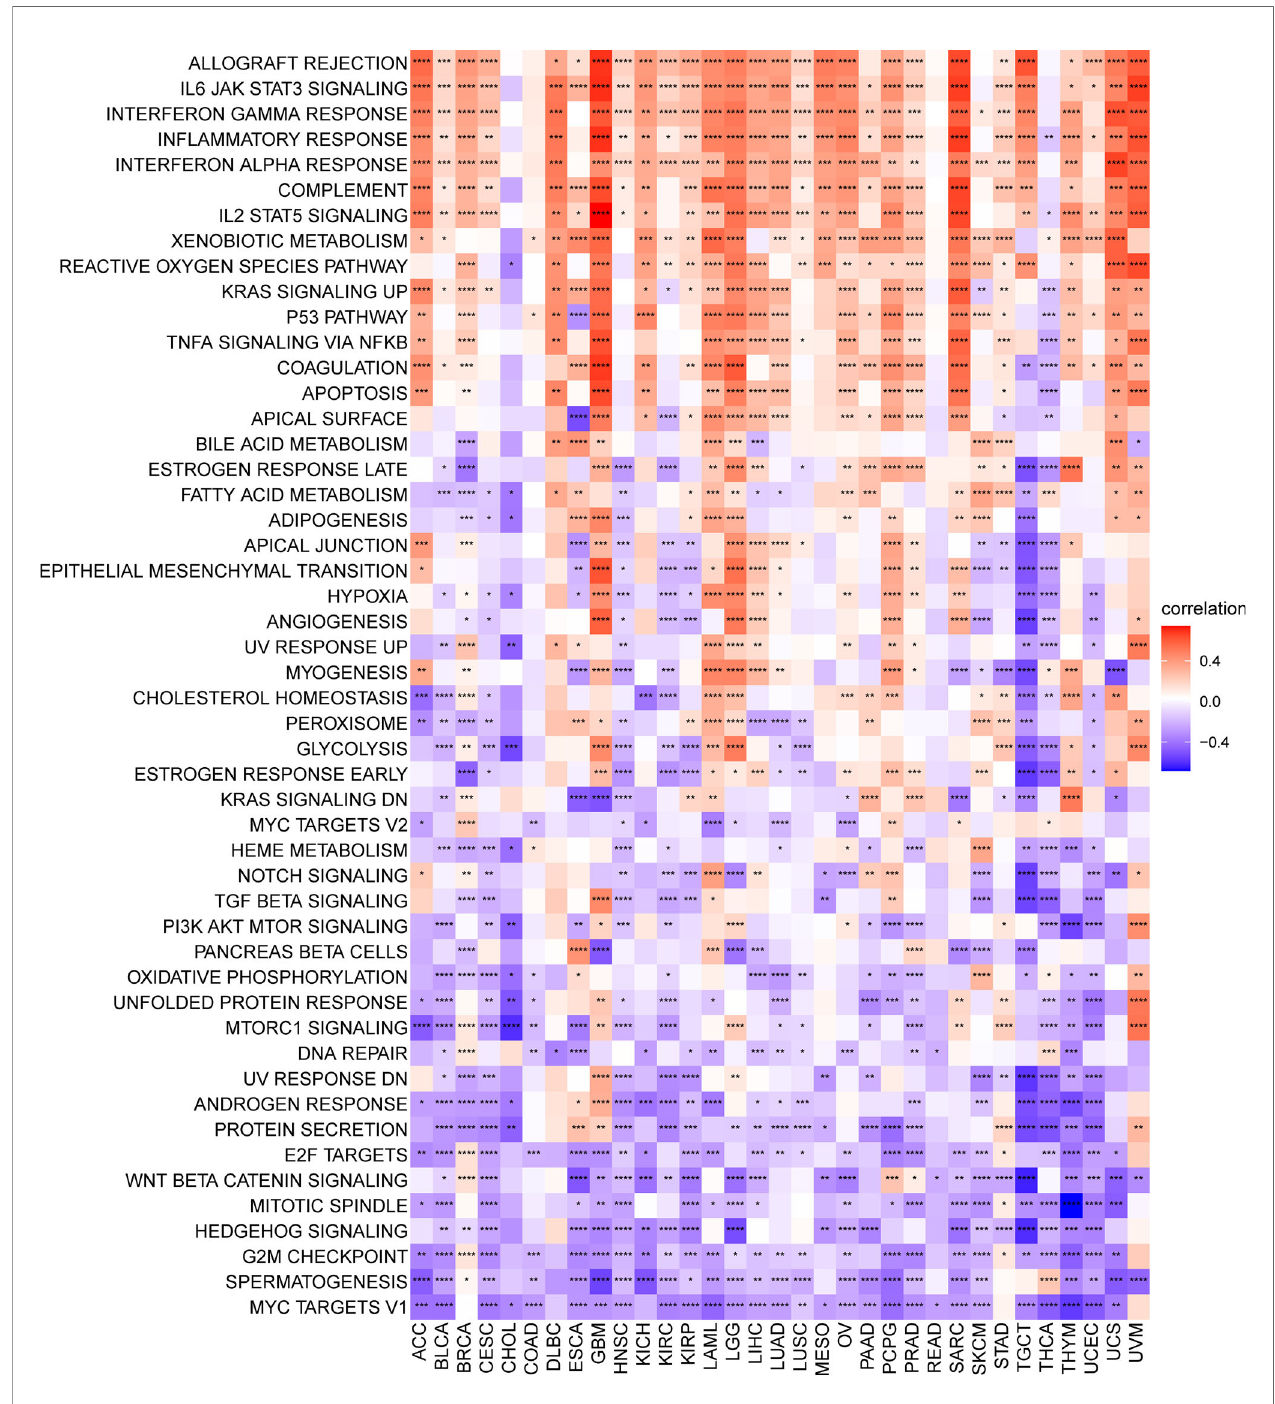
FIGURE 9 | GSVA of TRP score. Heatmap of the correlation between TRP score and 50 HALLMARK pathways in pan-cancer. * P < 0.05, ** P < 0.01, *** P < 0.001, **** P <